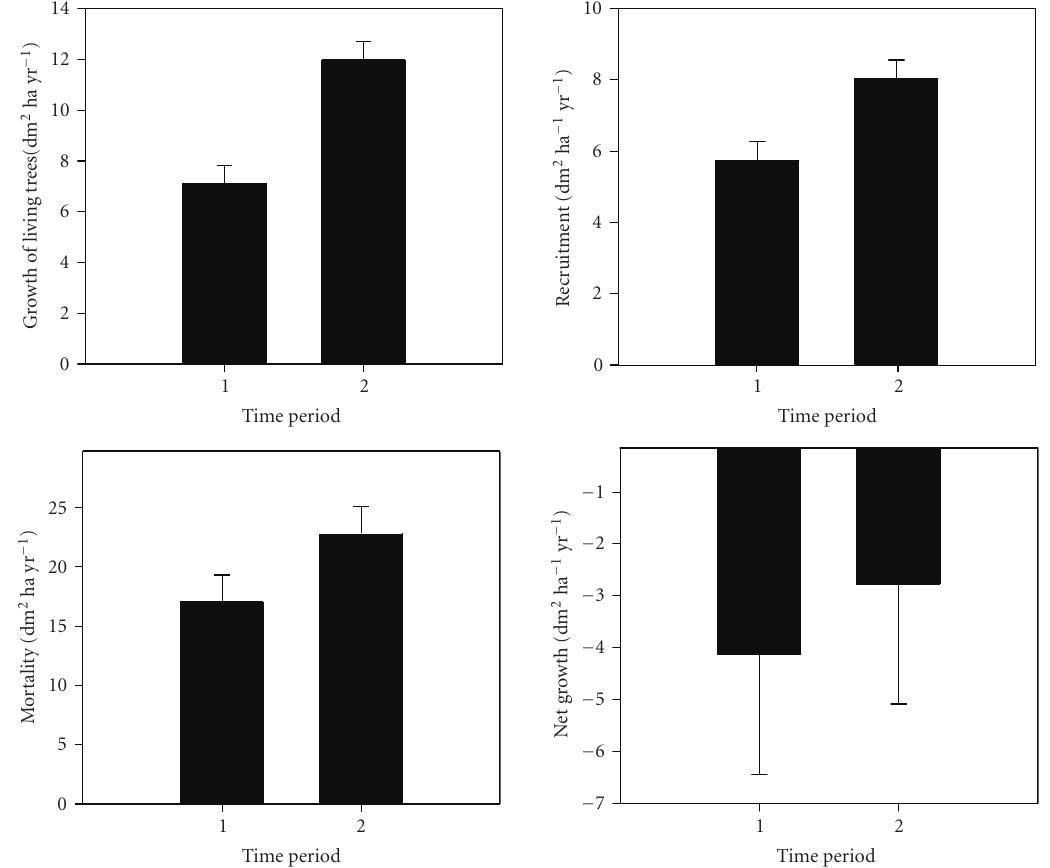
Figure 6: Tree growth and stand recruitment, mortality and net growth during two time periods: (1) 1970–1975 to 1978–1980 and (2) 1990–1992 to 1998–2001.